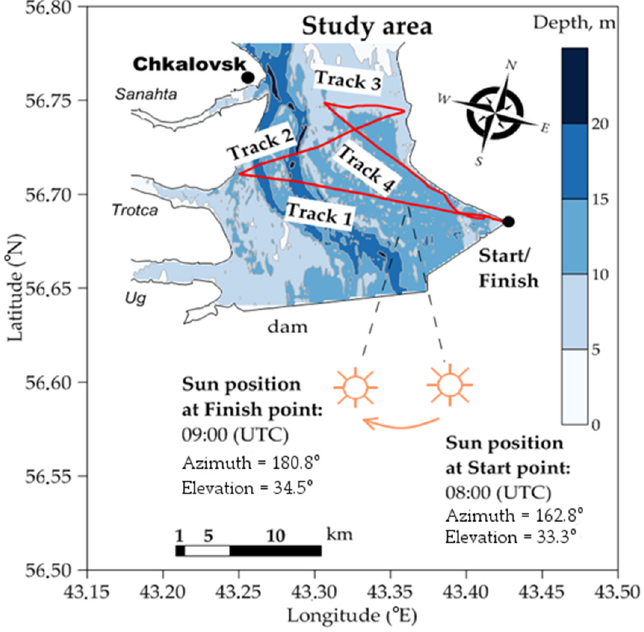
Figure 3. Motorboat route on 22 September 2018.